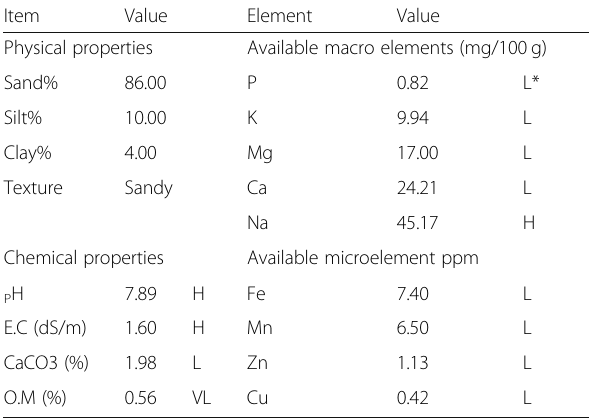
Table 1 Physical and chemical analyses of the experimental soil (average of the two seasons) Item Value Element Value Physical